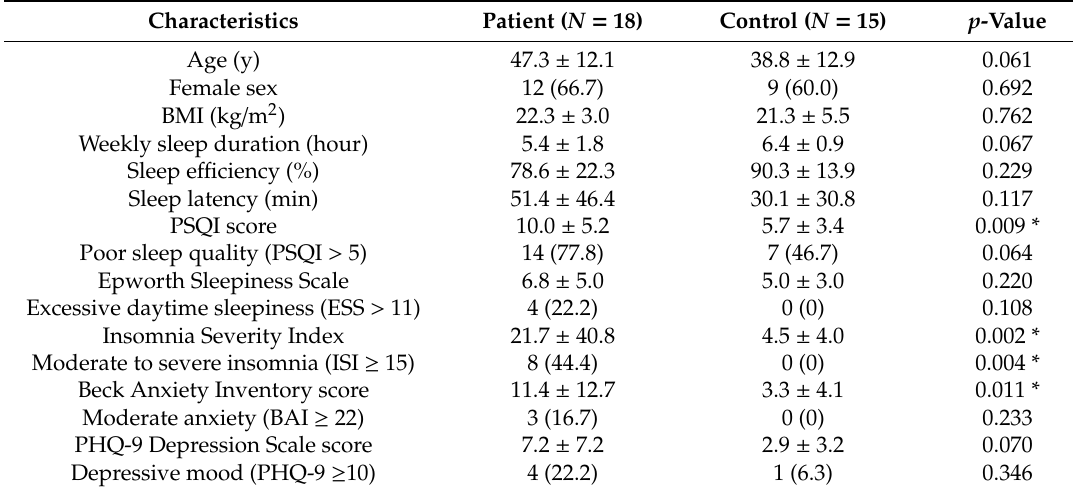
Table 1. Demographic and clinical characteristics of restless legs syndrome (RLS) patients and the control